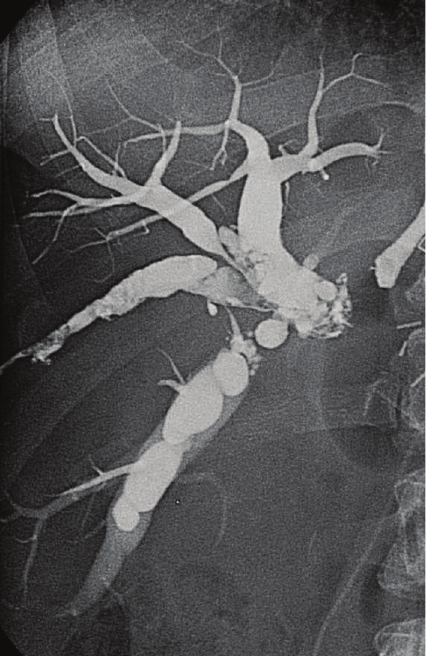
Figure 3: Intraoperative cholangiogram showing the complete filling with glue of excluded intrahepatic bile